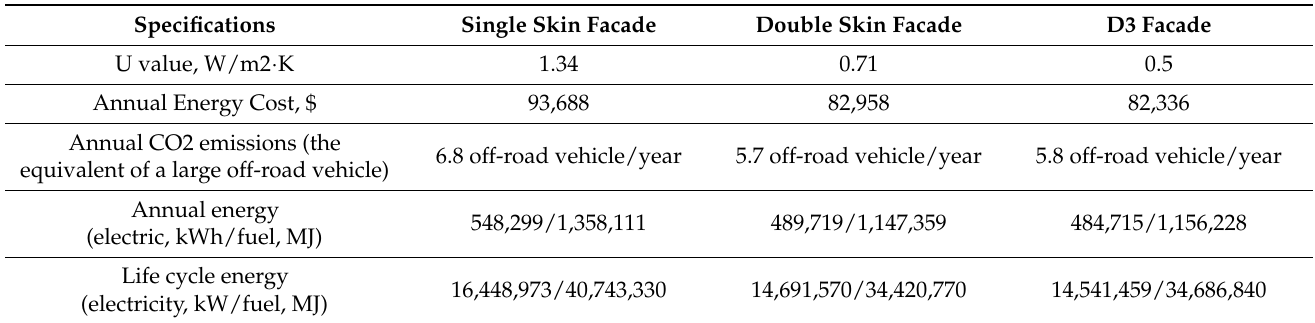
Table 4. Design characteristics of the multi-skin